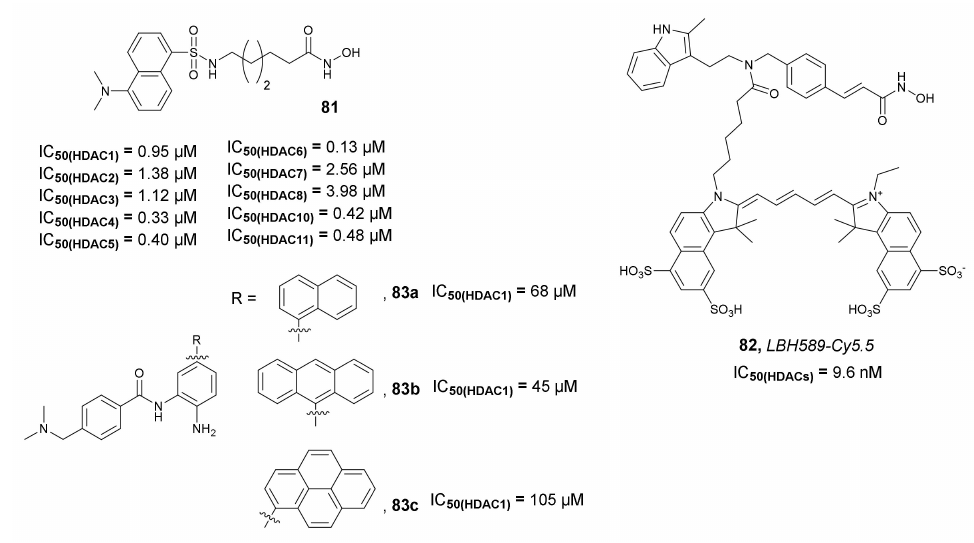
Figure 28. Chemical structure of compounds 81 – 83